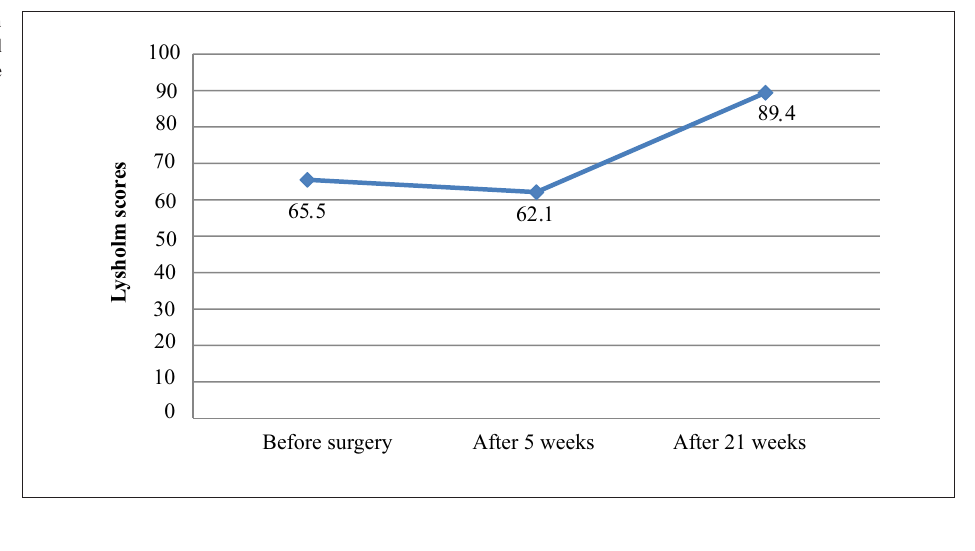
Before surgery After 5 weeks Figure. Changes in Lysholm Functional Scale scores over time (p < 0.05)